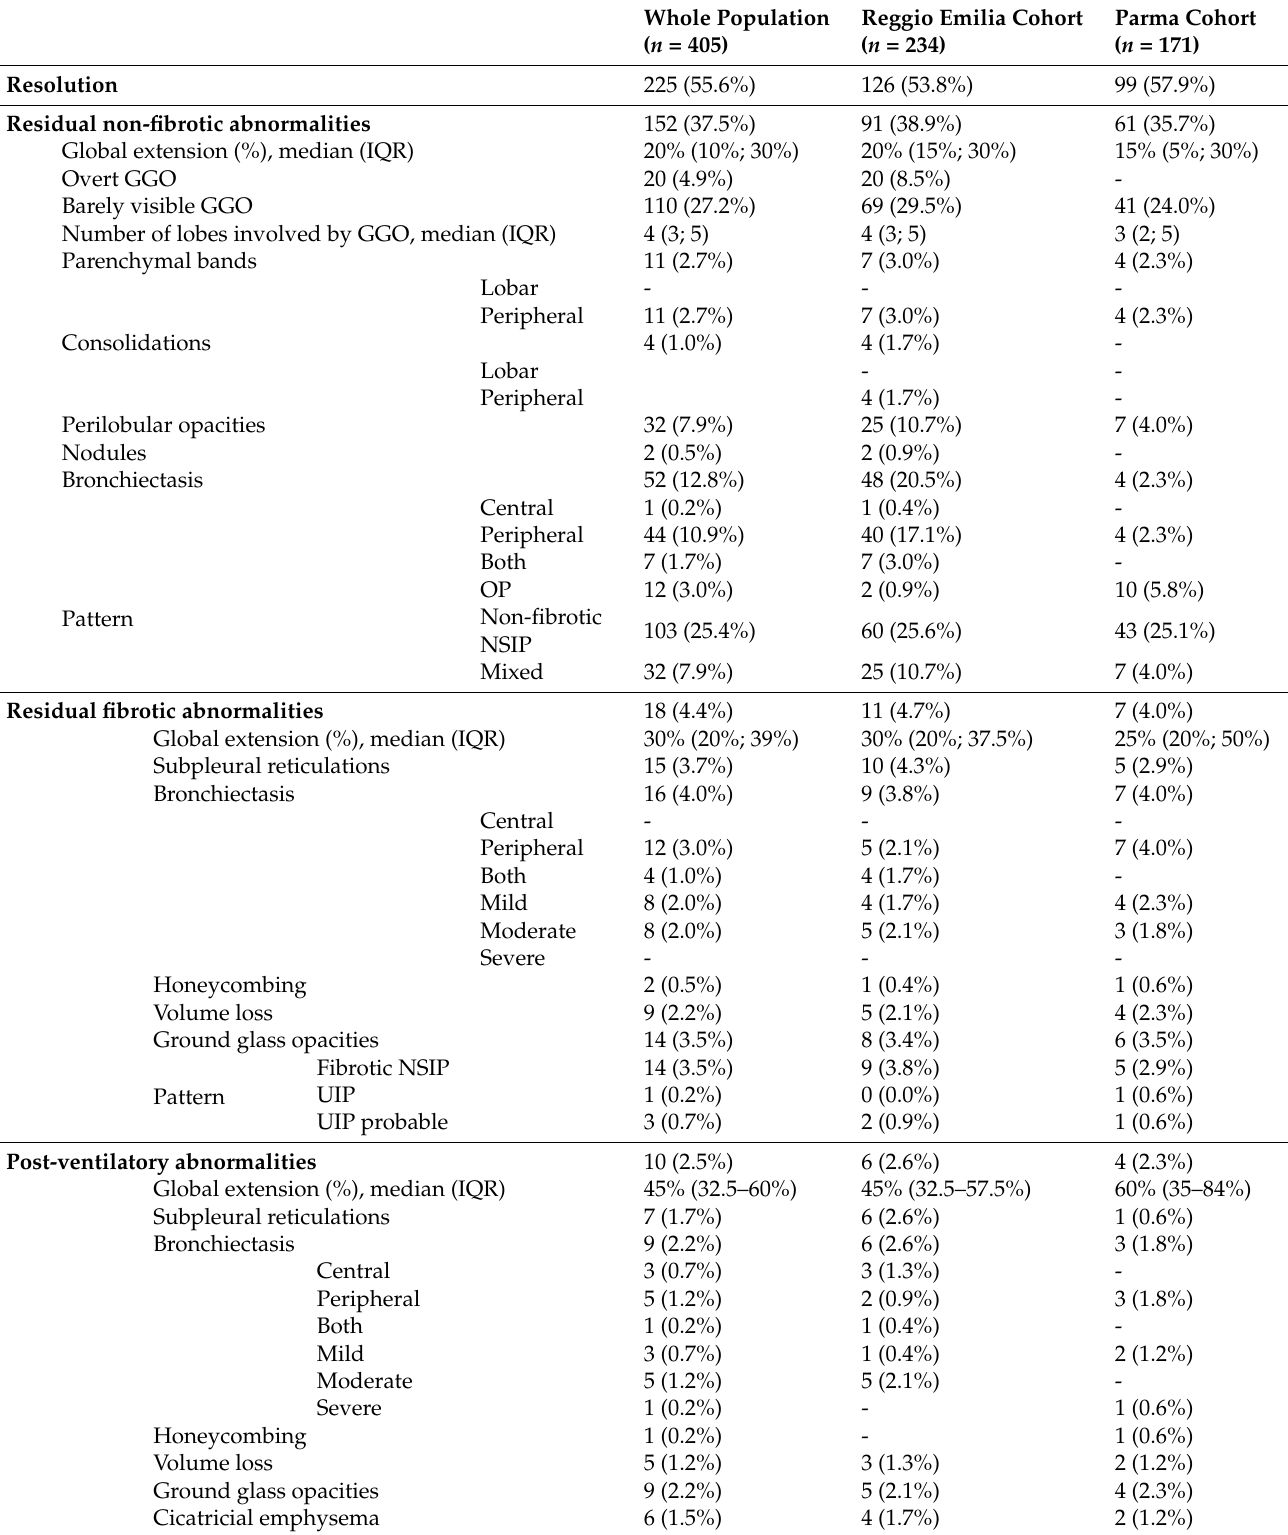
Table 2. 5–7-month follow-up CT scan patterns and individual abnormalities in the whole population and in the two cohorts separately. IQR, Interquartile range; GGO, ground glass opacities; NSIP, nonspecific interstitial pneumonia; OP, organizing pneumonia; UIP, usual interstitial